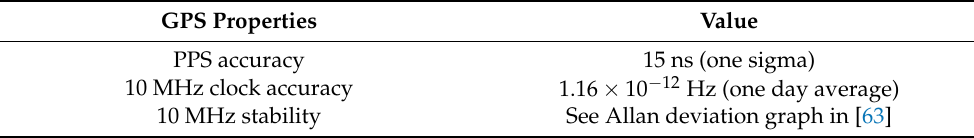
Table 2. GPS disciplined oscillator